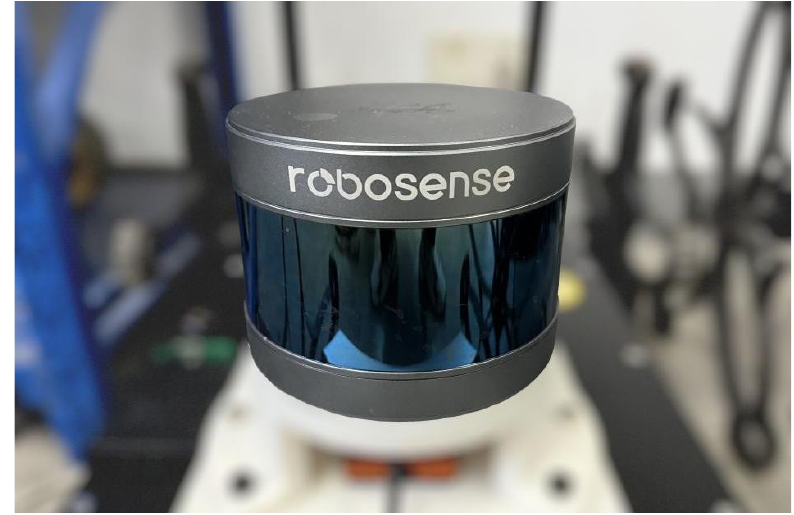
Figure 12. RS-LiDAR-16 used in our test.